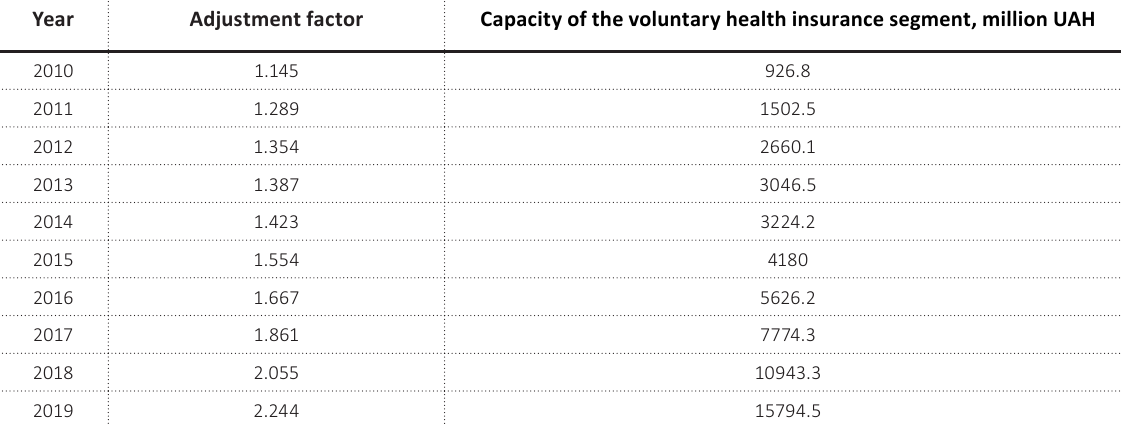
Table 2. Results of calculations of the adjustment factor and capacity of the segment of voluntary health insurance in Ukraine for the period 2010–2019 Capacity of the voluntary health insurance segment, million UAH